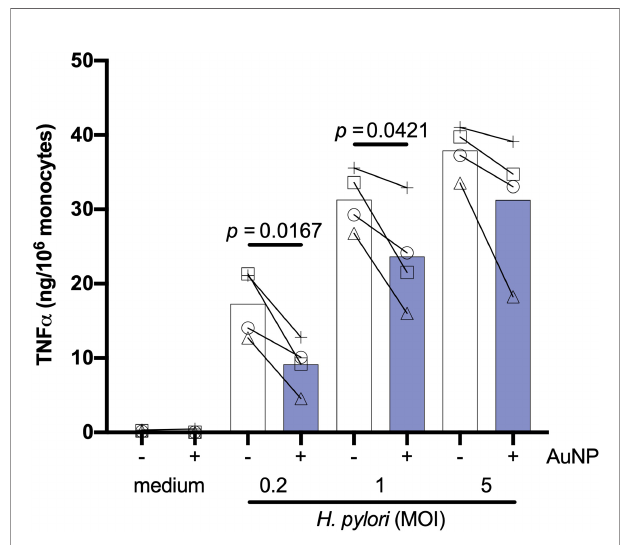
FIGURE 5 | Effect of AuNPs on the primary response of monocytes to live H. pylori . CD14 + monocytes were stimulated with medium alone or containing live H. pylori (MOI: 0.2, 1, 5) for 24 h in the presence or absence of AuNPs (20 µg/mL, indicated by blue bars). The in fl ammatory response is reported in terms of production of TNF a (ng/10 6 monocytes). Values from individual donors are depicted concurrent with mean cytokine production. p values are indicated when < 0.05 for the comparison between stimulation with or without NPs, n =